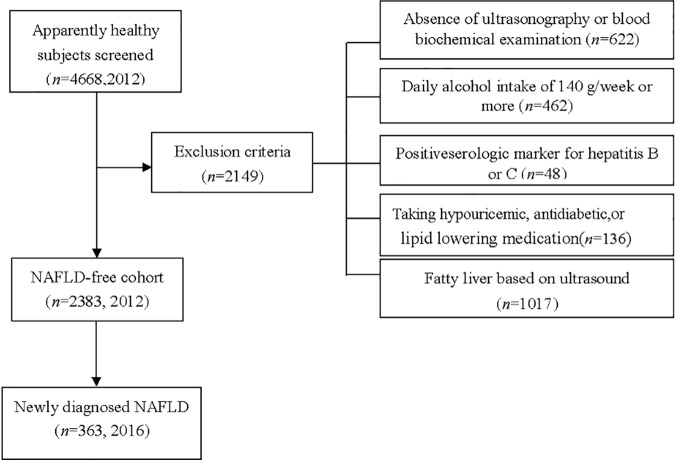
Flow diagram of subjects’ selection.A total of 4668 employees underwent health screening in 2012, of which 2149 subjects were excluded due to following reasons: absence of ultrasonography or blood biochemical examination; with heavy drinking (daily alcohol intake of 140 g/week or more); with a positive serologic marker for hepatitis B or C; diagnosed with fatty liver based on ultrasonography; taking hypouricemic, antihypertensive, antidiabetic and lipid lowering medication. Consequently, 2383 subjects were observed for incident NAFLD after 4 years.